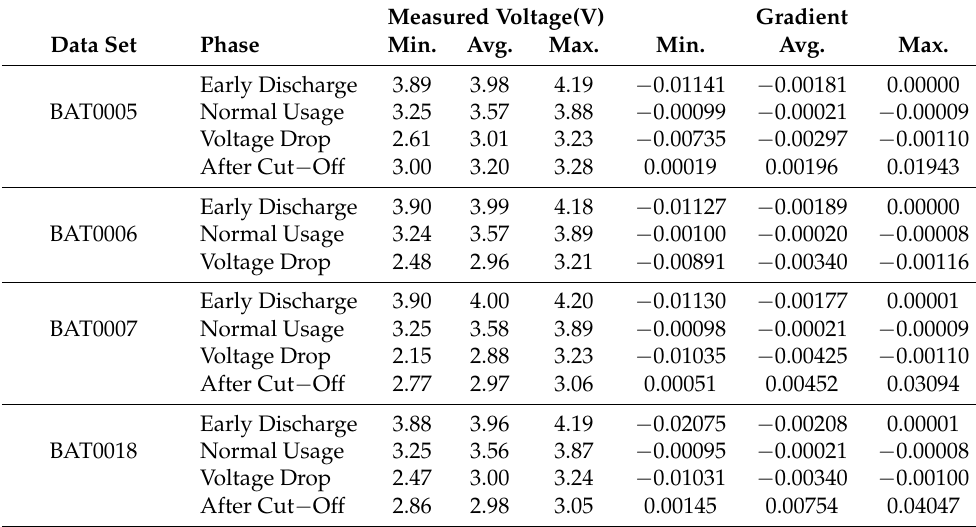
Table 2. Statistical data from gradient vector